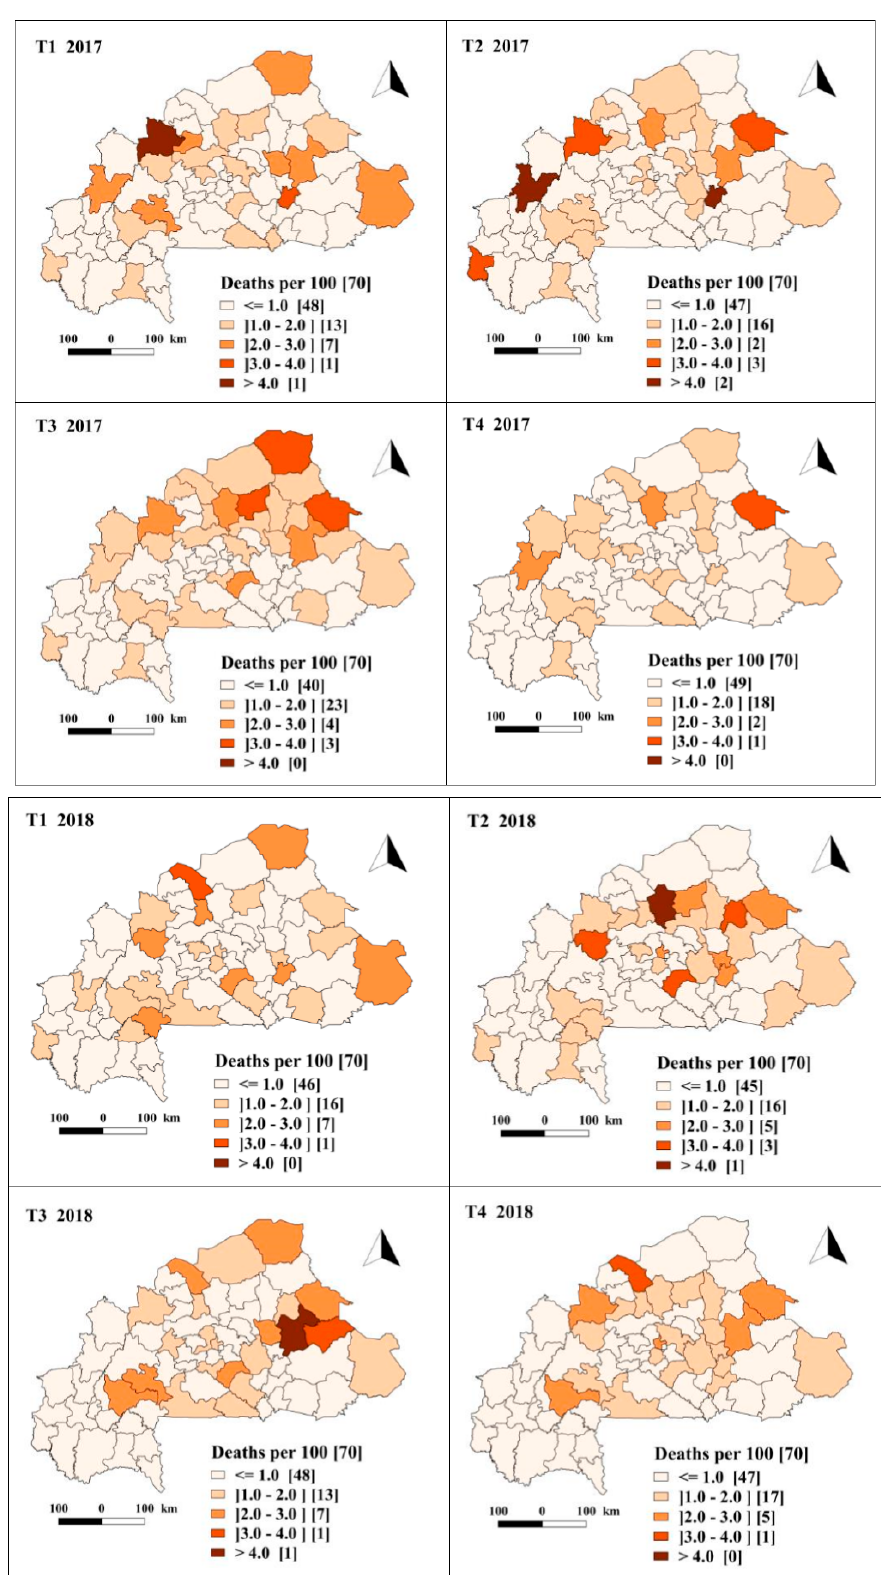
Figure A1. Spatiotemporal trends in the crude mCFR in children under five (January 2013–December 2018. T1, T2, T3 and T4 represents the first, second, third and fourth trimester of each year respectively.